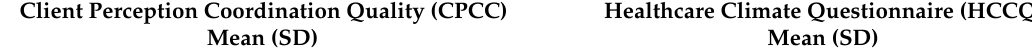
Table 3. Summary of Client Perception Coordination Quality and Healthcare Climate Questionnaire by